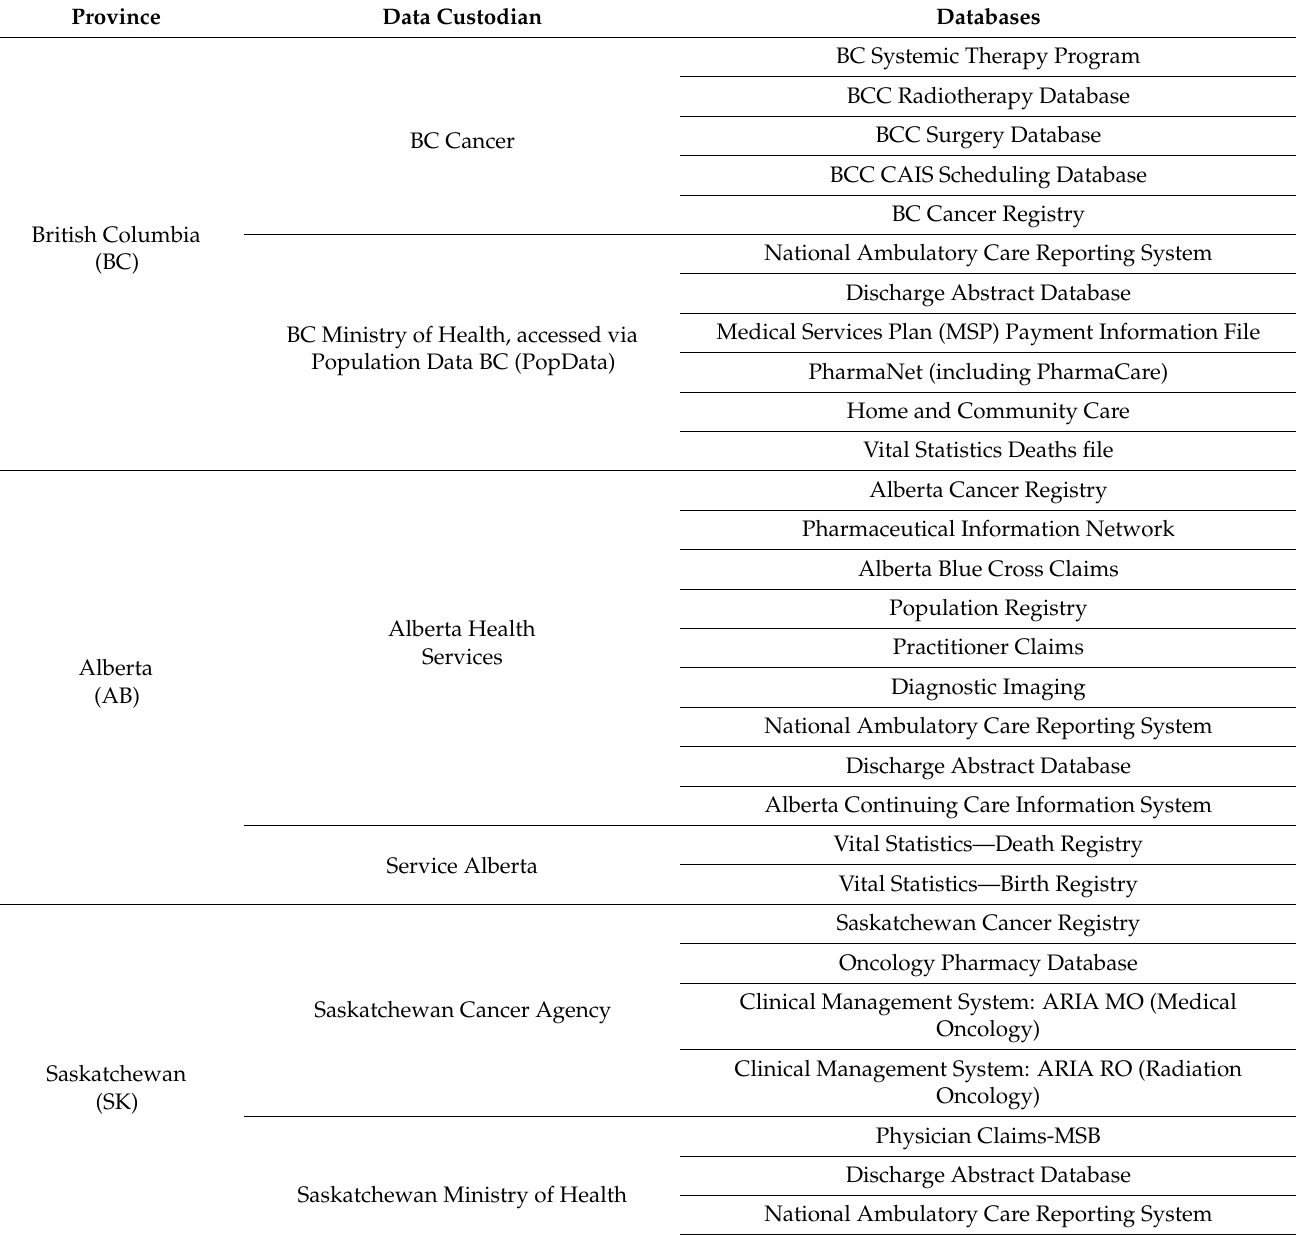
Table 1. Summary of databases in